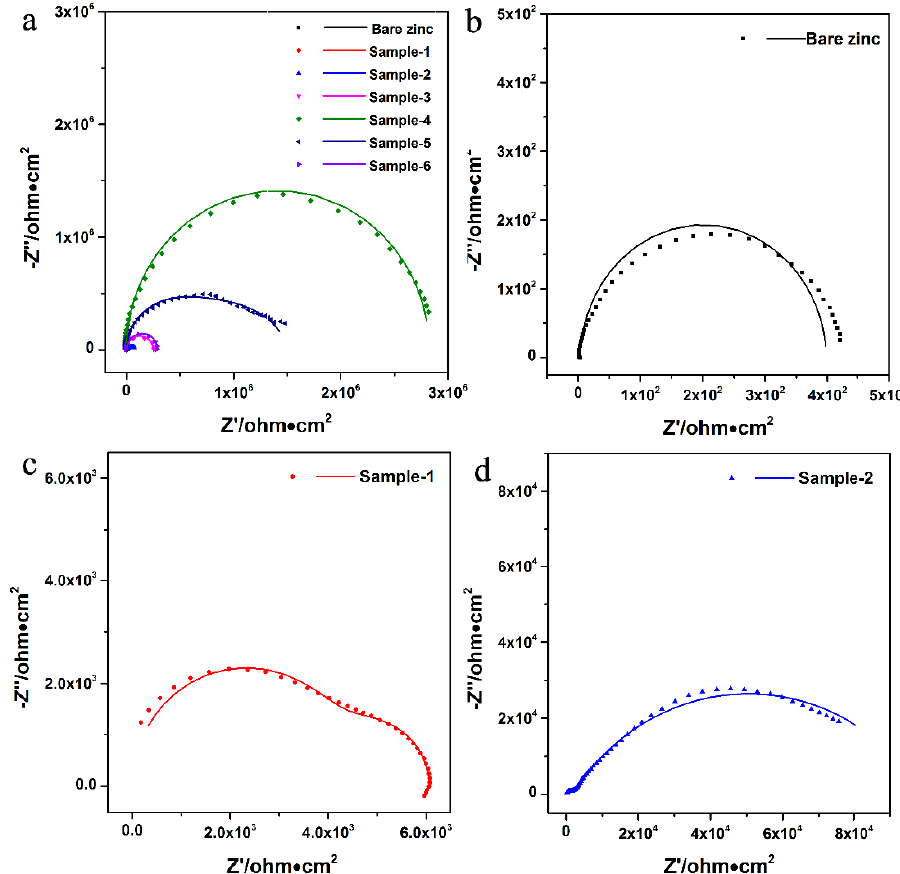
Figure 5. ( a ‒ d ) Nyquist plots of electrochemical impedance spectroscopy (EIS) (dots) and fits of a ZsimpWin (version 3.60, lines) operated immersed in a 3.5% NaCl solution at room temperature (25 °C). The R 2 values from EIS data of bare zinc, Sample 1, Sample 2, Sample 3, Sample 4, Sample 5 and Sample 6 were 0.9625, 0.9376, 0.9967, 0.9025, 0,9499 and 0.9448, respectively.